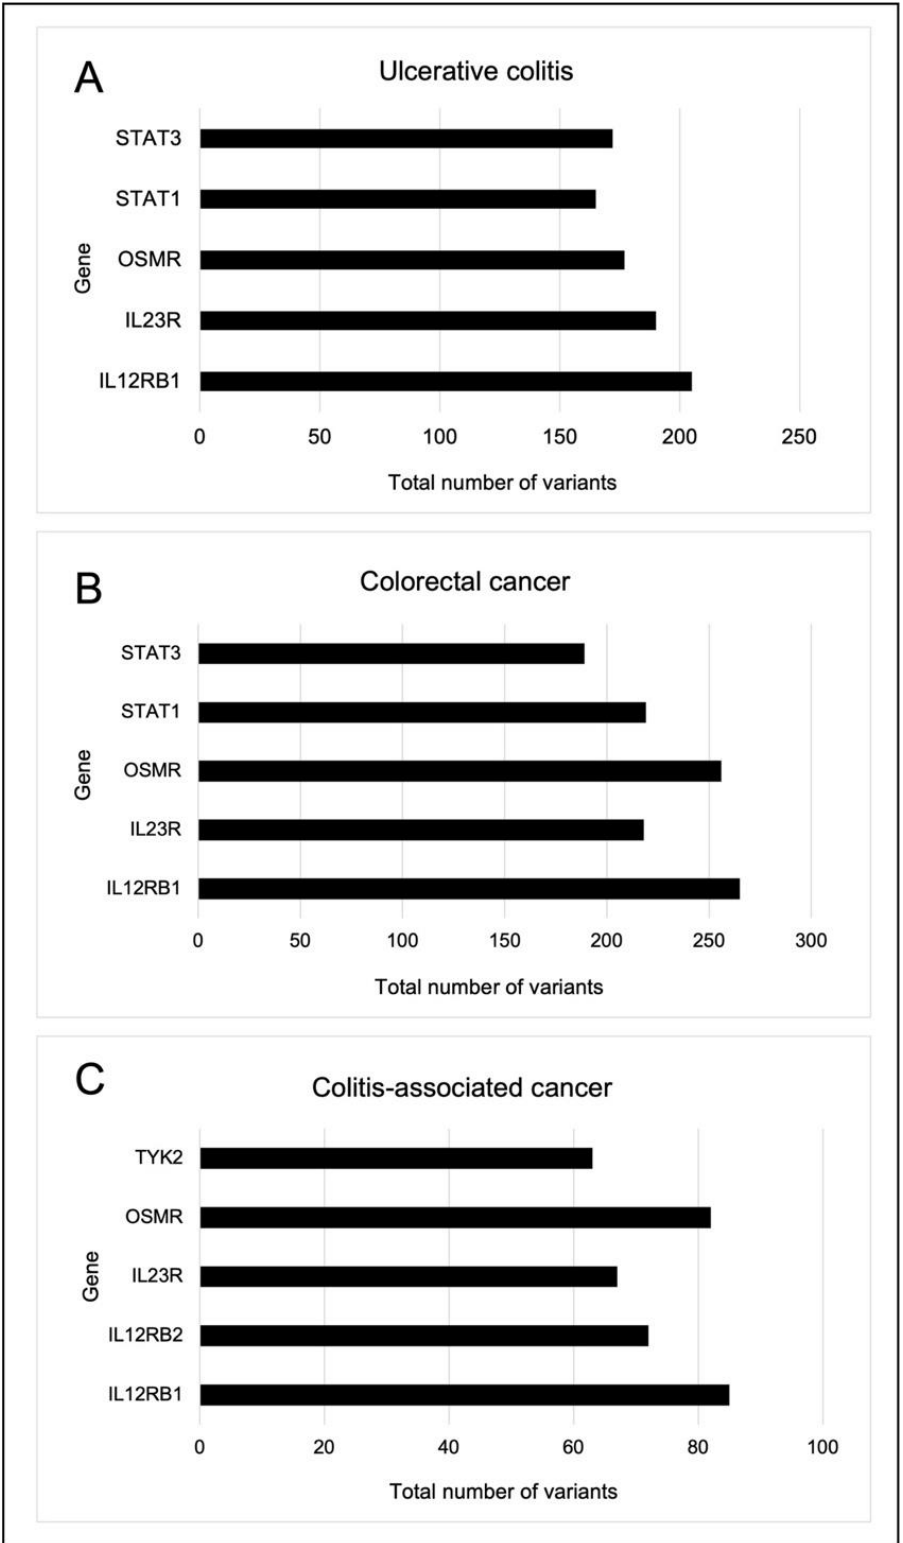
Figure 4. The top five altered genes for each group are shown in a bar graph. ( A ) Ulcerative colitis ( B ) Colorectal cancer, and ( C ) Colitis-associated cancer groups.